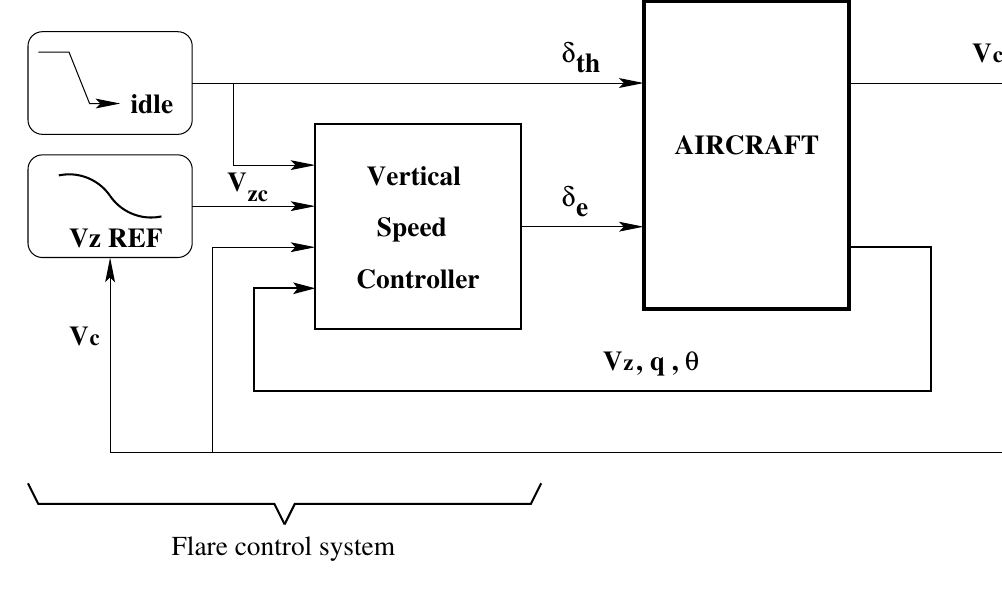
Figure 3. Flare control